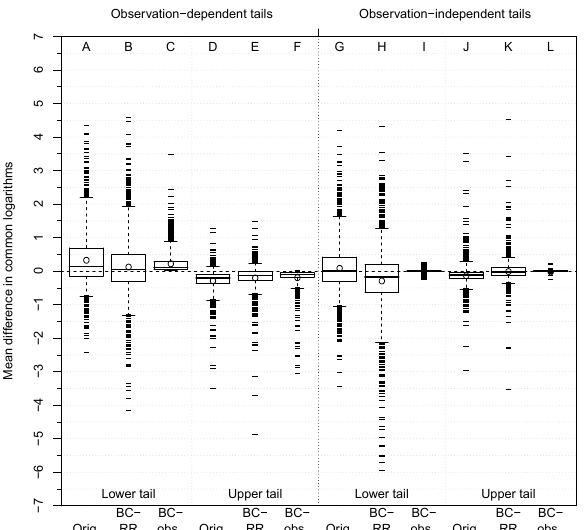
obs.− −−−−−−−−−−−−−− BC− BC− BC− BC− BC− BC− BC− BC− BC− BC− BC− BC− BC− BC− BC− BC− obs.− Orig. RR obs. Orig. RR obs. Orig. RR obs. Orig. RR Orig. RR obs. Orig. RR obs. Orig. RR obs. Orig. RR Figure 5. Distribution of logarithmic bias, measured as the mean Figure 6. Distribution of logarithmic accuracy, measured as the difference between the common logarithms of simulated and root mean squared error between the common logarithms of sim- observed streamflow at 1168 streamgages across the contermi- ulated and observed streamflow (simulated minus observed) at nous USA for observation-dependent and observation-independent 1168 streamgages across the conterminous USA for observation- upper and lower tails. Observation-dependent tails retain the dependent and observation-independent upper and lower tails. ranks of observed streamflow, while matching simulations by day. Observation-dependent tails retain the ranks of observed stream- Observation-independent tails rank observations and simulation in- flow, while matching simulations by day. Observation-independent dependently. The upper tail considers the highest 5% of stream- tails rank observations and simulation independently. The upper tail flow, while the lower tail considers the lowest 5% of streamflow. considers the highest 5% of streamflow, while the lower tail consid- Orig. refers to the original simulation with pooled ordinary krig- ers the lowest 5% of streamflow. Orig. refers to the original simula- ing, BC-RR refers to the Orig. hydrograph bias-corrected with re- tion with pooled ordinary kriging, BC-RR refers to the Orig. hydro- gionally regressed flow duration curves, and BC-Obs. refers to graph bias-corrected with regionally regressed flow duration curves, the Orig. hydrograph bias-corrected with observed flow duration and BC-Obs. refers to the Orig. hydrograph bias-corrected with ob- curves. The tails of the box plots extend to the 5th and 95th per- served flow duration curves. The tails of the box plots extend to the centiles of the distribution; the ends of the boxes represent the 5th and 95th percentiles of the distribution; the ends of the boxes 25th and 75th percentiles of the distribution; the heavier line in the represent the 25th and 75th percentiles of the distribution; the heav- box represents the median of the distribution; the open circle rep- ier line in the box represents the median of the distribution; the open resents the mean of the distribution; outliers beyond the 5th and circle represents the mean of the distribution; outliers beyond the 95th percentile are shown as horizontal dashes. 5th and 95th percentile are shown as horizontal